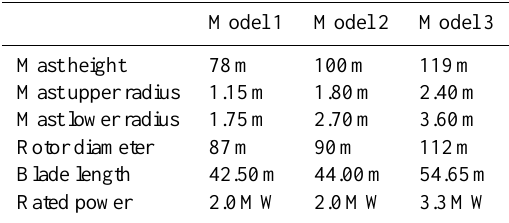
Table 1. Wind turbine models selected for the